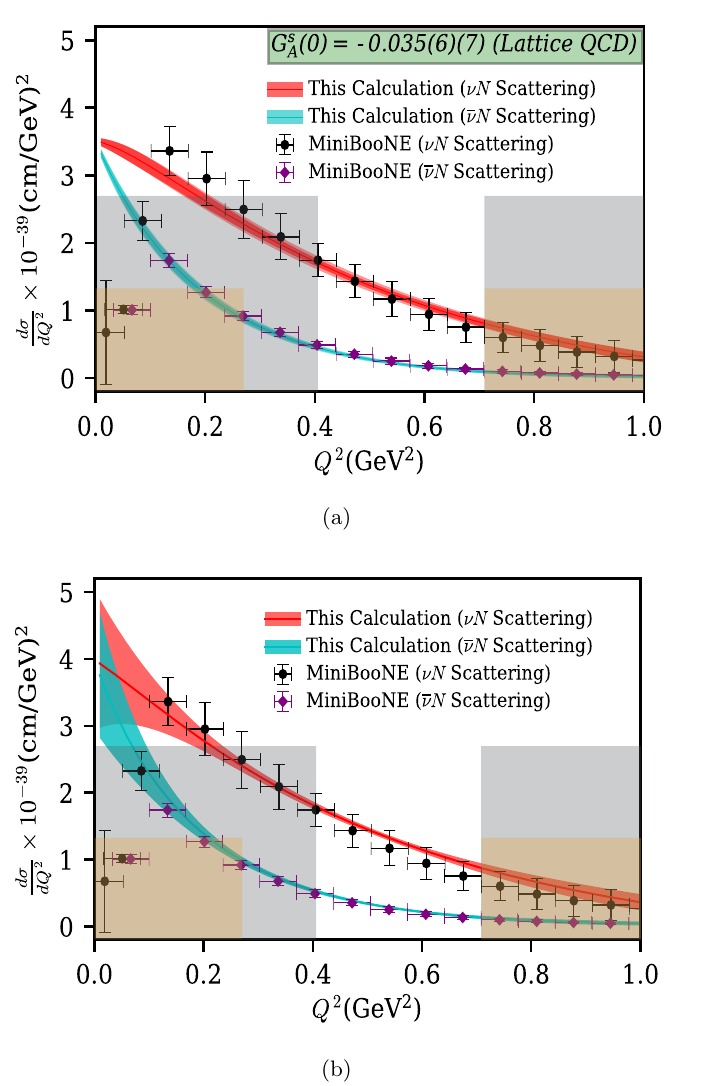
Figure 2 . Comparison of the ( (cid:23) ) (cid:23) (cid:0) N di(cid:11)erential cross section between our analysis and Mini- BooNE extractions. (a) shows the di(cid:11)erential cross sections obtained using the (cid:12)t parameters of G Z ( Q 2 ) from table 1 when lattice QCD estimate of G s A z -expansion (cid:12)t. The uncertainty coming from neutrino beam energy (cid:14)E as a systematic error in the d(cid:27)=dQ 2 extraction and shown in the outer light red and light cyan bands in (a). (b) shows the di(cid:11)erential cross sections obtained using the z -expansion (cid:12)t results presented in table 1 without using the direct determination G Z The shaded gray and orange indicate the value of Q 2 excluded in our determination of G Z for the (cid:23) (cid:0) N and (cid:23) (cid:0) N scattering data, respectively. The lowest four Q 2 data points for (cid:23) (cid:0) N scattering are compiled from ref.